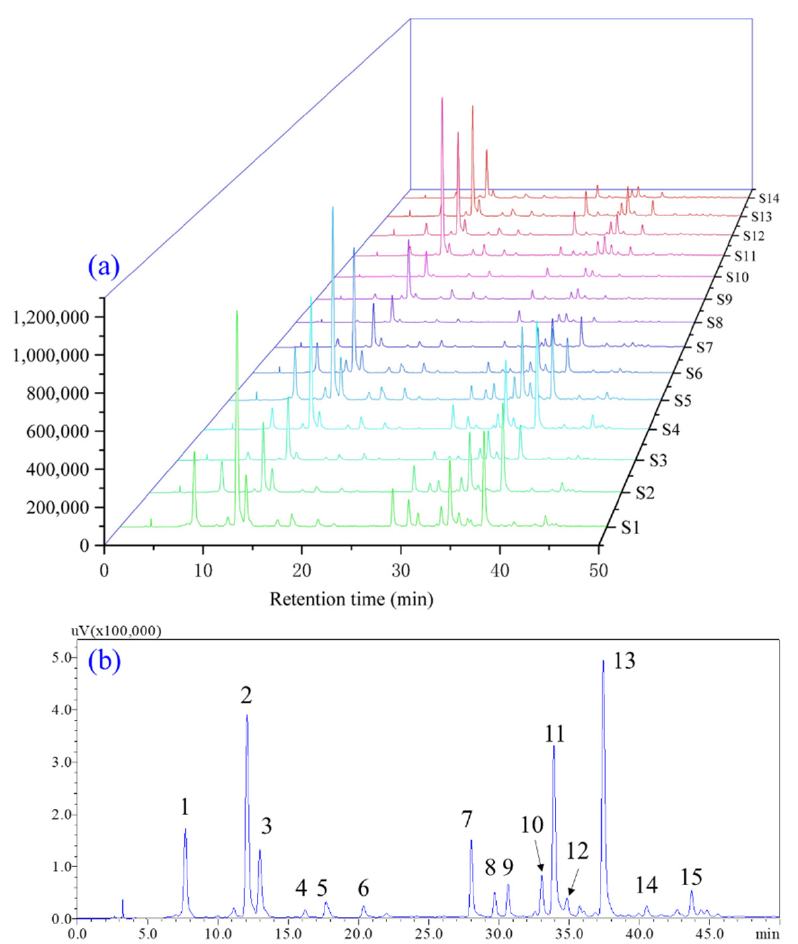
Figure 3. The typical ( a ) HPLC fingerprints of 14 A. quinata leaves samples from different cities and reference fingerprint of A. quinata leaves ( b ). 1: neochlorogenic acid; 2: chlorogenic acid; 3: crypto- chlorogenic acid; 4: unknown; 5: 5- O - p -coumaroylquinic acid; 6: 5- O -feruloylquinic acid; 7: rutin; 8: quercetin-3- O -glucoside; 9: unknown; 10: nictotiflorin, 11: isochlorogenic acid A, 12: astragalin; 13: isochlorogenic acid C, 14: unknown; 15: unknown.